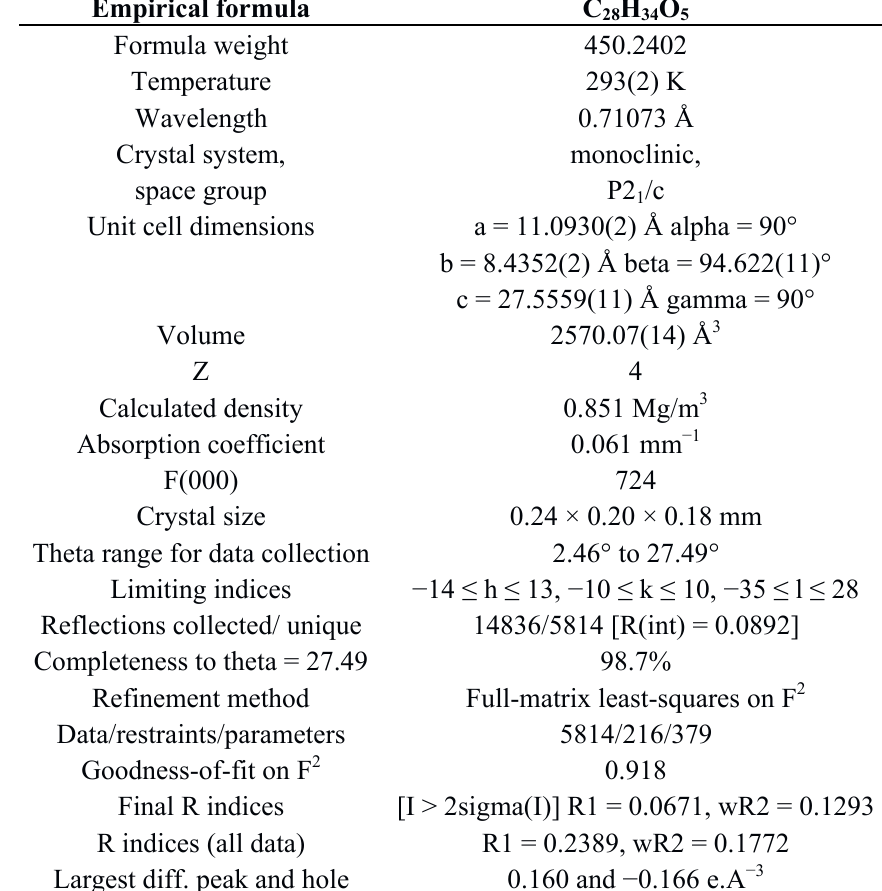
Table 1. Crystal data and structure refinement for ( ‒ )-encecanescin ( 1